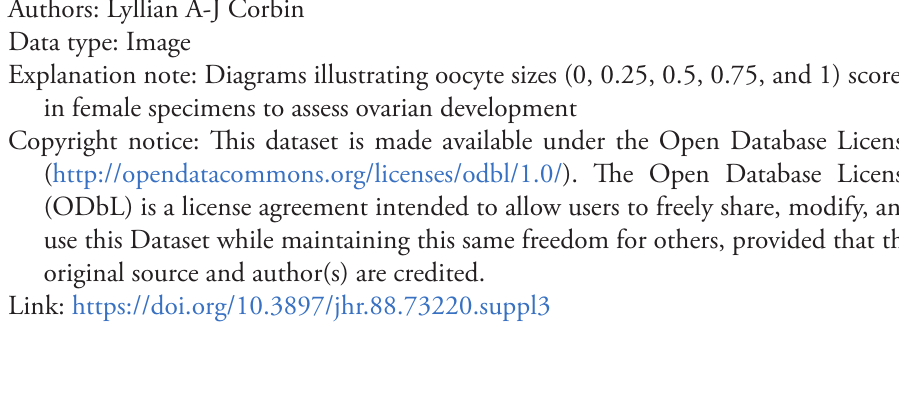
Figure S3. Scoring systems for ovarian development scores. Authors: Lyllian A-J Corbin Data type: